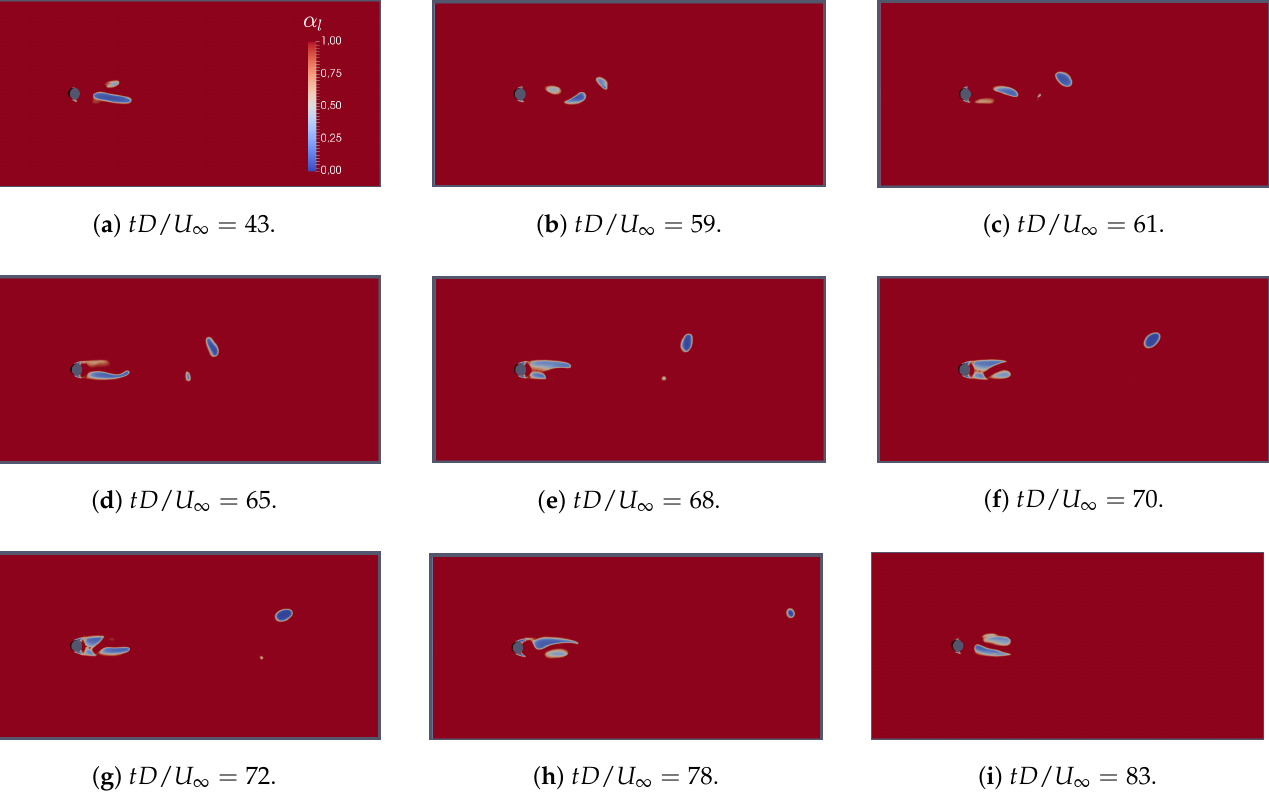
Figure 5. Contour plot of instantaneous liquid fraction obtained with Kunz model and considering standard coefficients.